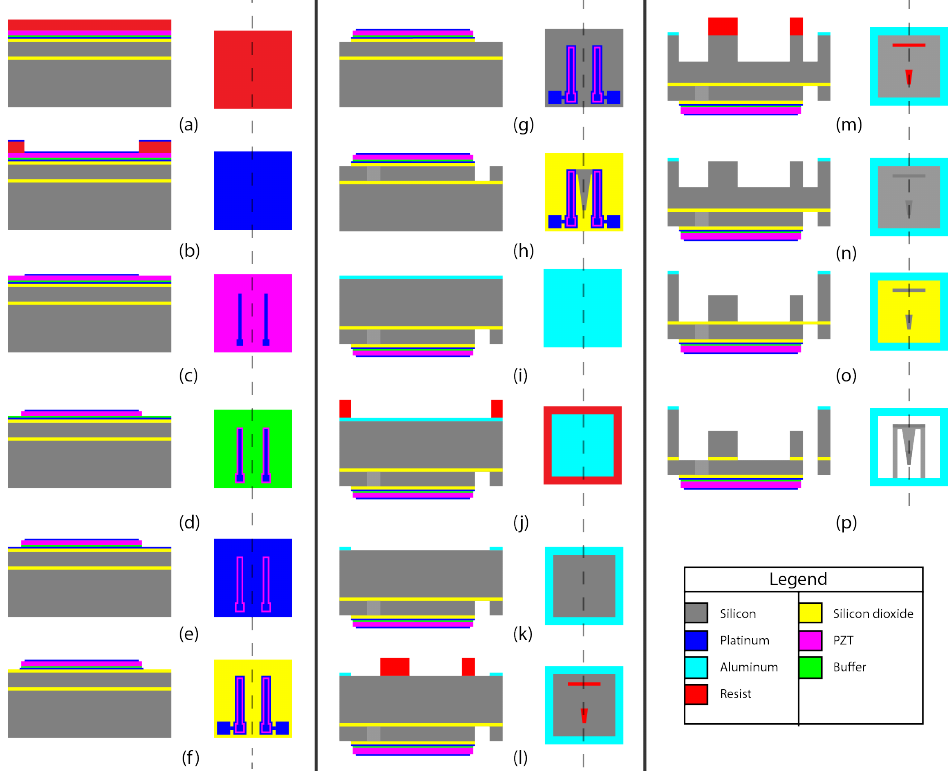
Figure 7. Schematic process plan for fabricating cantilevers. The left side on each panel is a cross section of the top view of the substrate. Topside Processing : A 6” SOI wafer with 1.1 µ m lead zirconate titanate (PZT), 100 nm buffer oxide and 120 nm bottom electrodes: ( a ) photoresist spinning; ( b ) Pt/Ti deposition on patterned resist; ( c ) top electrode lift-off; ( d ) PZT wet etching; ( e ) buffer oxide etching; ( f ) bottom electrode etching; ( g ) photoresist spinning to protect the electrodes; ( g ) SiO 2 etching; and ( h ) silicon DRIE etching, 20 µ m. Backside processing : ( i ) Aluminum sputtering; ( j ) resist deposition